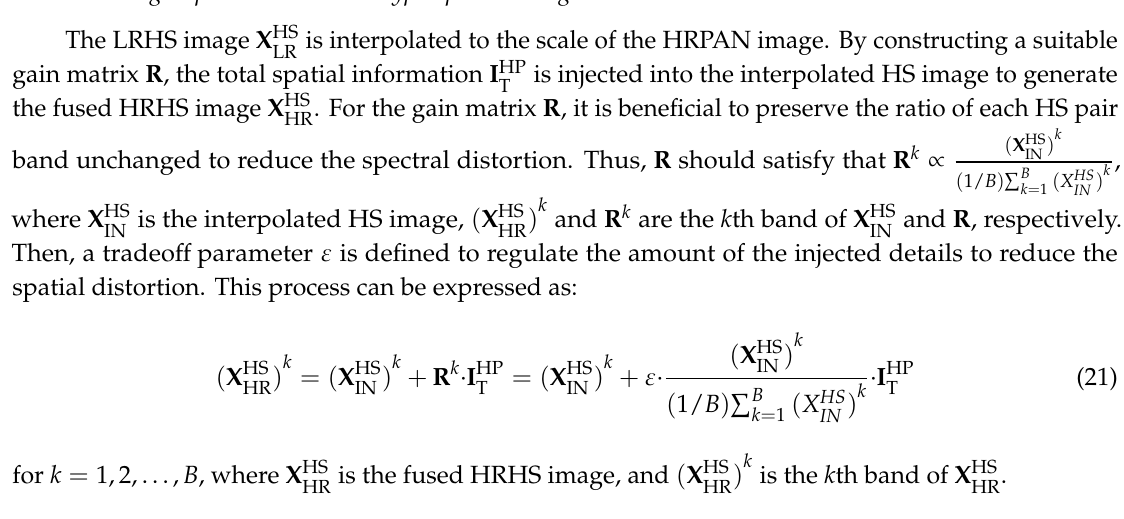
I ; ( c ) Enhanced PAN image PAN I ; ( d ) HR s